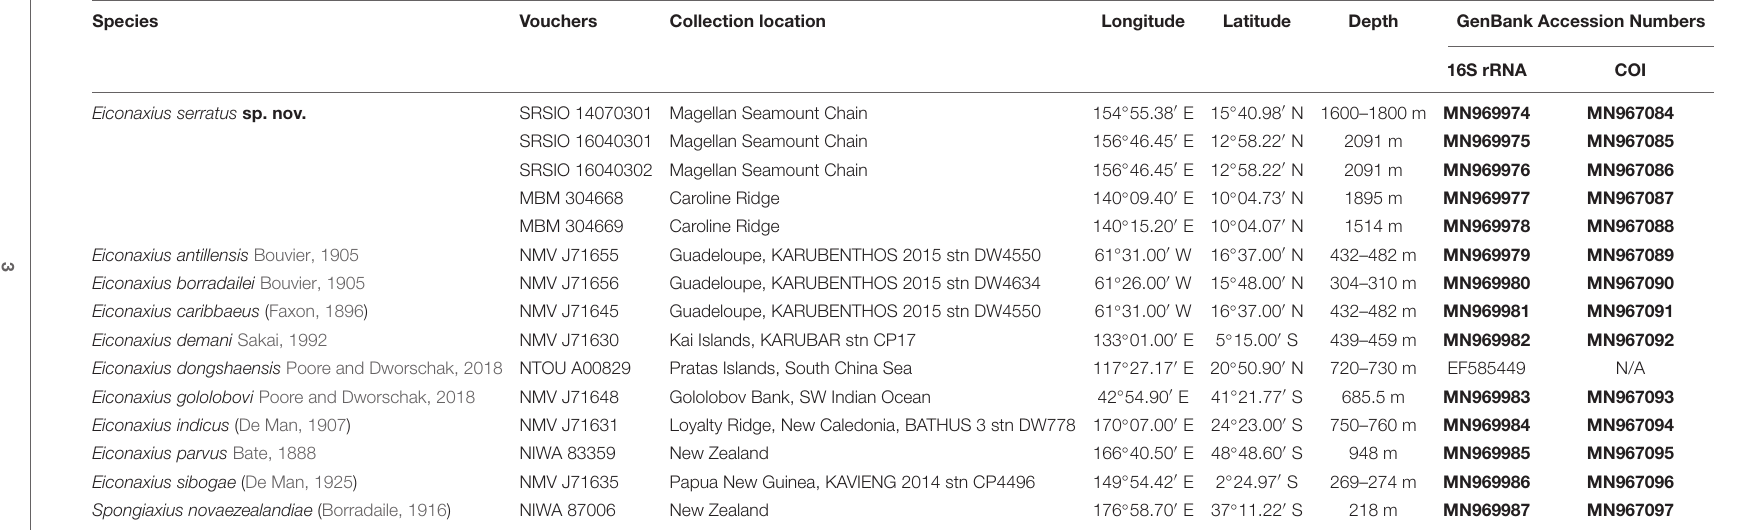
New sequences are in